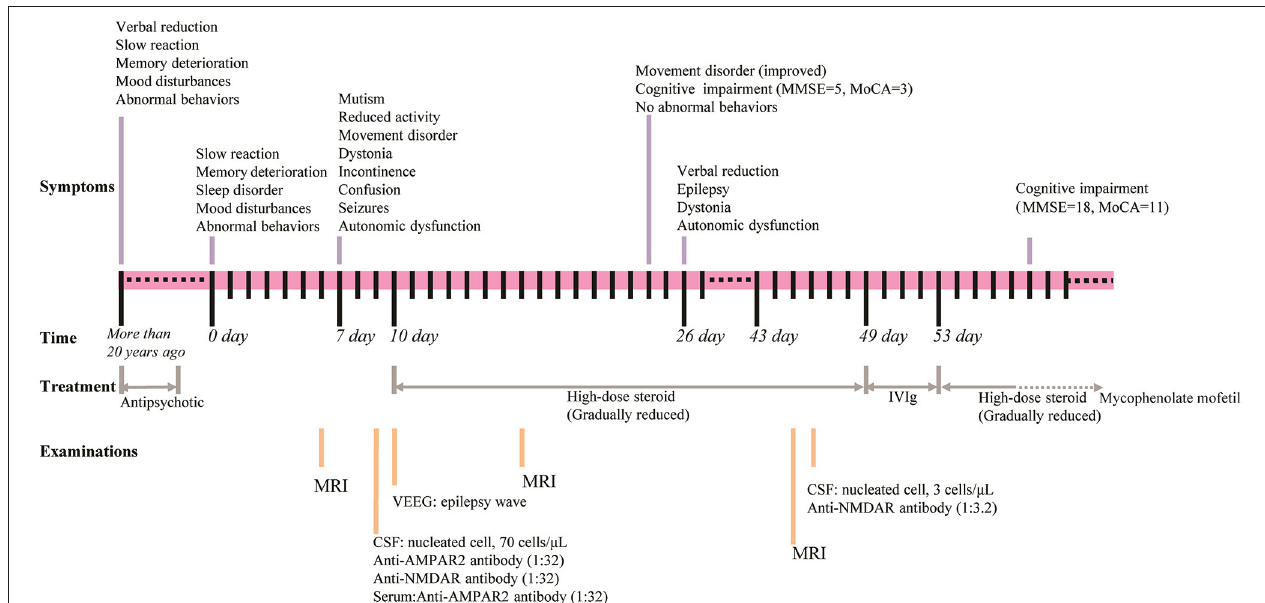
FIGURE 1 | Timeline for the course of the case. Upper part shows the symptoms, middle shows the time and the treatment, and lower part shows the examinations conducted.